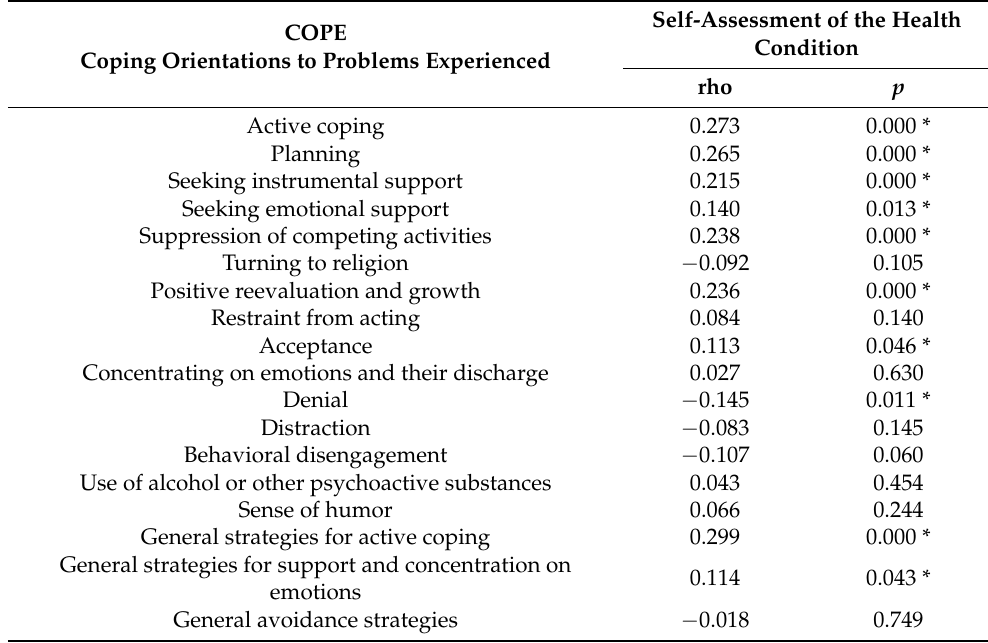
Table 2. Correlations between self-assessment of the health condition and strategies of coping with disease.